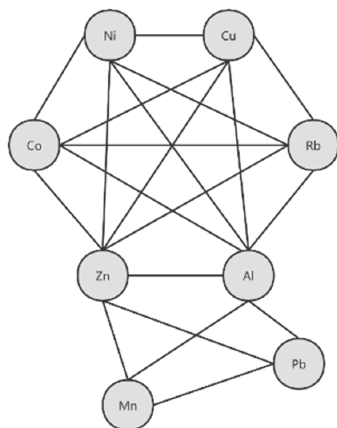
Figure 4. Toxic and essential trace elements’ correlation network in maternal plasma of pregnant women.